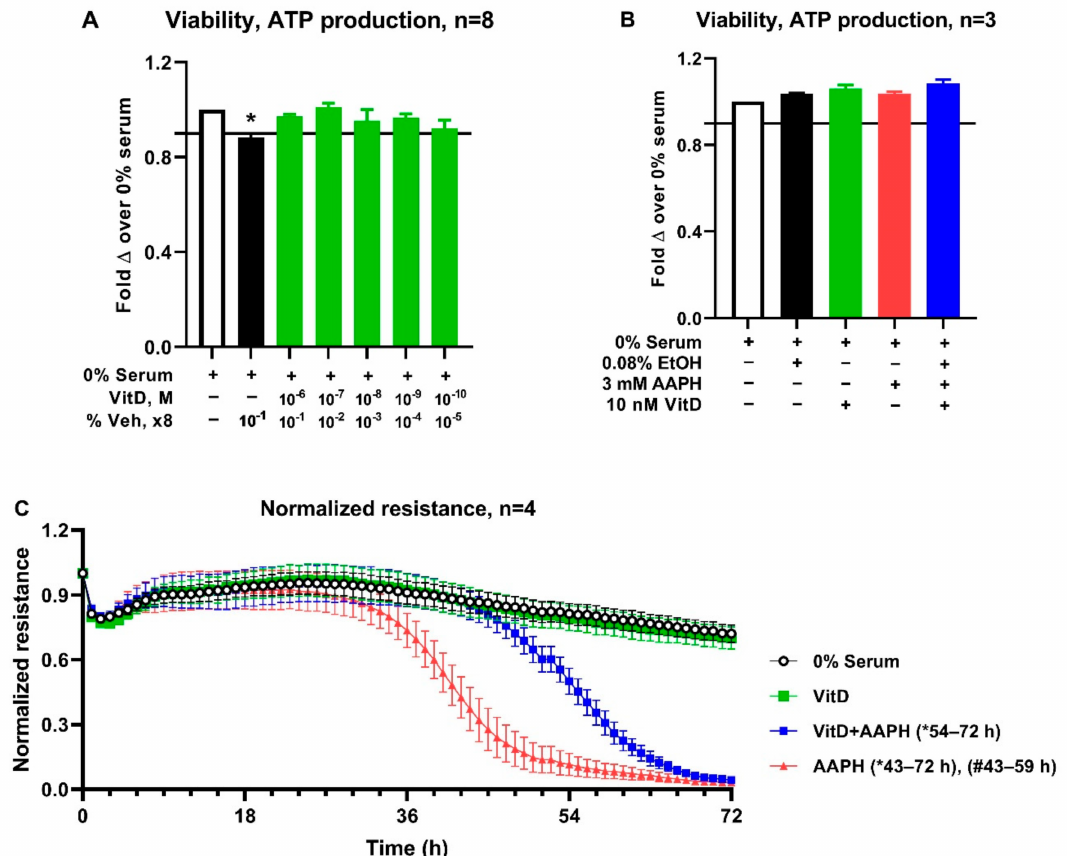
Figure 1. Effect of Calcitriol (vitamin D) on barrier integrity of BAEC treated with AAPH. A dose-response curve was performed to test physiological vitamin D concentrations (10 − 6 M–10 − 10 M) on cell viability for 24 h ( A ). The highest vitamin D concentration (10 − 7 M) maintaining at least 90% viability relative to untreated control was assessed for effect on barrier integrity in cells exposed to 3 mM AAPH ( C ). The viability of BAEC in cells exposed to treatments for the duration of barrier integrity assessment was determined ( B ). Viability data were each compared to untreated control and analyzed by the one-way ANOVA with Dunnett’s post hoc adjustment for multiple comparisons. Two-way repeated-measures ANOVA analyzed barrier integrity data with Tukey adjustment for multiple comparisons. Asterisk (*) indicates a significant difference from untreated control for viability (1A) and barrier integrity (1C). Duration of differences in barrier integrity is indicated in parentheses in C. Pound (#) shows the comparison between treatment with 3 mM AAPH with 10 nM Vit D vs. 3 mM AAPH alone. For all comparisons, α =